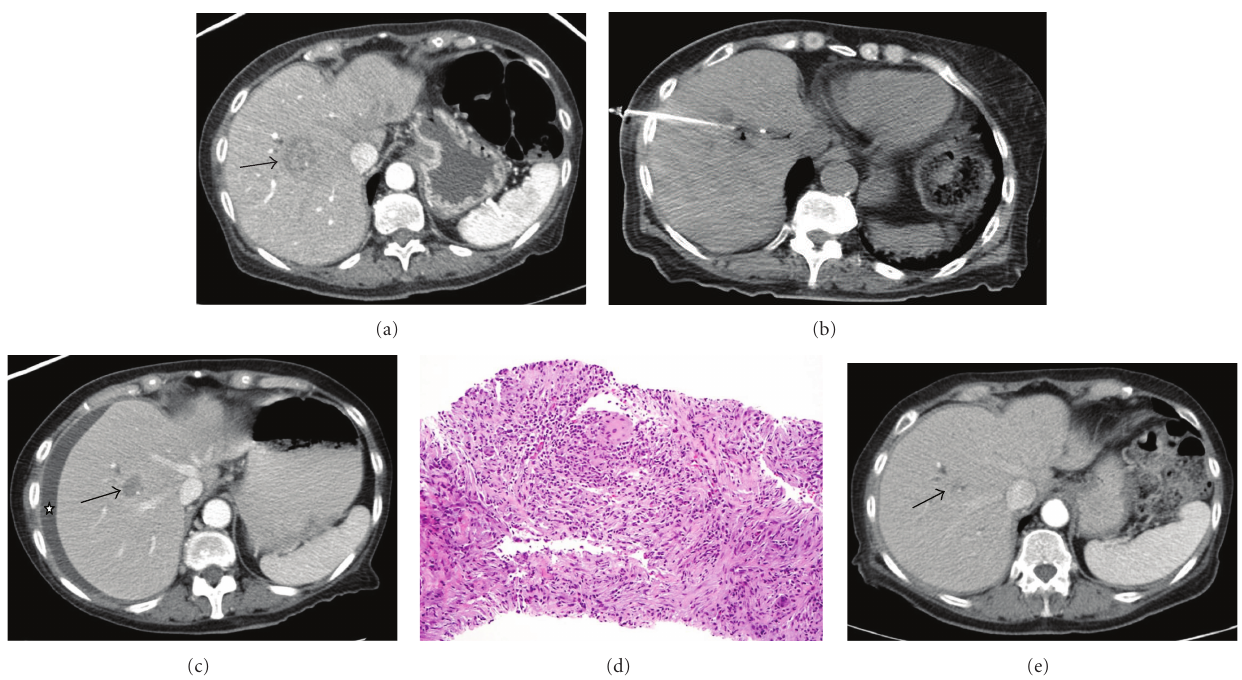
Figure 1: (a) Patient with history of cholangiocarcinoma status after pancreaticoduodenectomy. Axial contrast-enhanced CT image obtained a few weeks after surgery demonstrates one of the two new hepatic lesions in segment 8 (arrow). (b) Axial image from CT guided needle biopsy of the same lesion. The biopsy needle is placed within the lesion to obtain one of core samples. (c) Axial contrast-enhanced CT image one day after biopsy demonstrates new right perihepatic/subdiaphragmatic collection (asterix), which cultured positive for E. coli . The biopsied lesion is visible (arrow). (d) Histologic examination of core specimens shows a granuloma along with a mixed inflammatory infiltrate composed of lymphocyte, eosinophils, and neutrophils. (e) Contrast-enhanced CT image three months after biopsy shows resolution of liver lesions. The area of the biopsied segment 8 lesion is marked by an